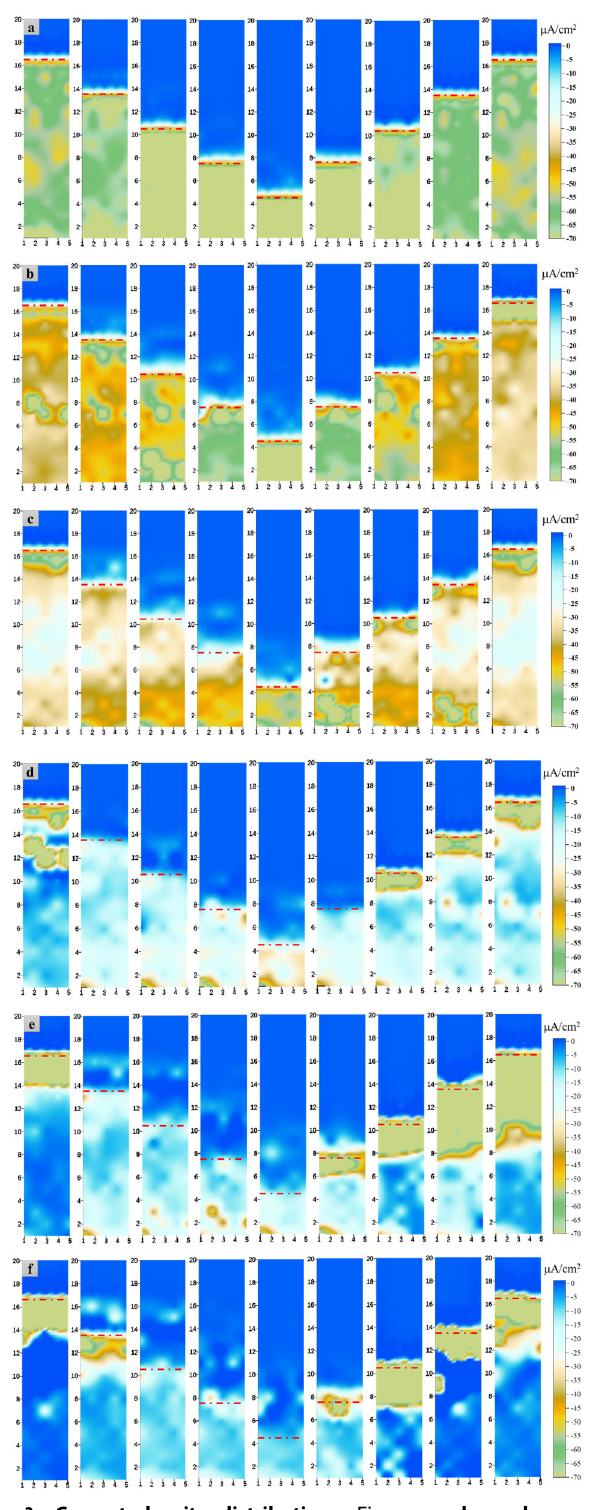
Fig. 2 Current density distributions. Figures a , b , c , d , e , and f represent the current density distributions on day 1, 4, 7, 15, 23, and 40 of experiment,